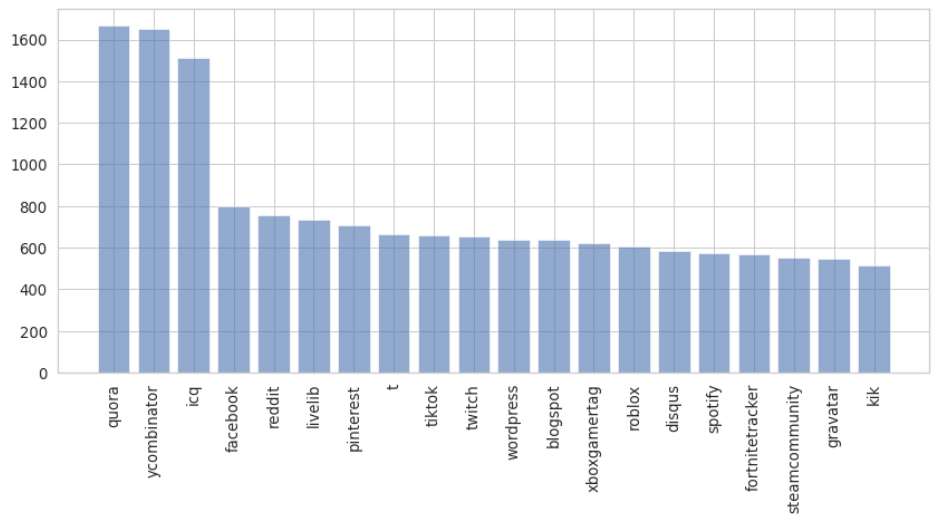
Figure 9. Top-20 social networks with BitChute accounts searched by username. x-axis shows the social networks and y-axis the number of account found in the